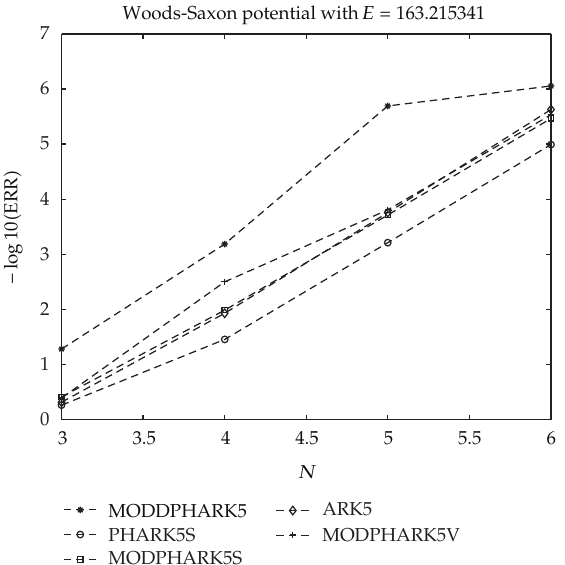
Figure 2: E ffi ciency curves for E (cid:7) 163 .